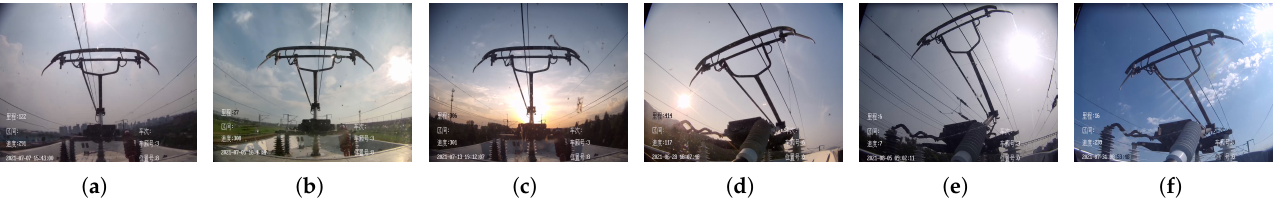
Figure 16. Sun did not affect YOLO detection of pantographs in HSR-A and HSR-B. ( a ) Case I. ( b ) Case II. ( c ) Case III. ( d ) Case IV. ( e ) Case V. ( f ) Case VI. The screen of the corresponding scene in Figure 16 after the high speed rail leaves the area affected by the sun is shown in Figure 17. Furthermore, the average grayscale of the corresponding scenes in Figures 16 and 17 is shown in Figure 18.